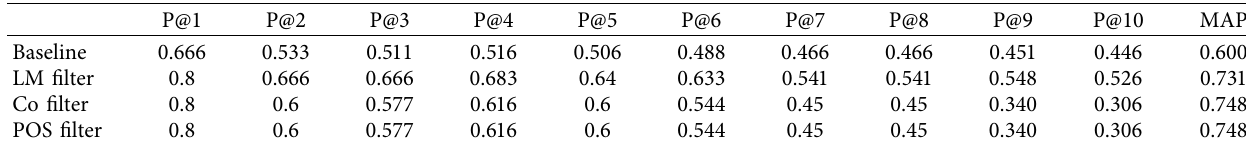
Table 16: The human evaluation results of applying the SynoExtractor pipeline on the Gigaword corpus.